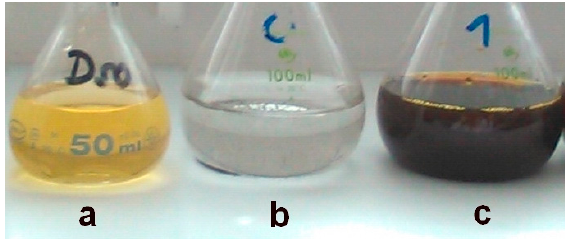
Figure 2. UV-VIS spectra of silver nanoparticles stabilized with gemini surfactants 12- s -12 with the spacer length s = 10, 12 methylene groups, at different molar ratio values n Ag /n 12- s -12 .